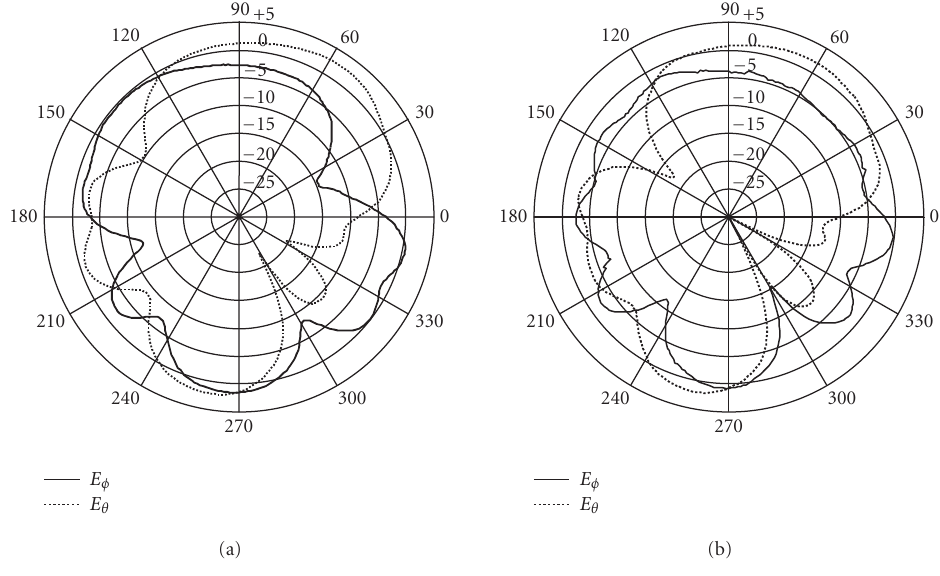
Figure 6: Measured radiation patterns (copolar and cross-polar) for two of the PIFAs in the outdoor-to-indoor campaign (Figure 5c) in the plane perpendicular to the faceplate and parallel to the length axis of the terminal: (a) top left antenna and (b) top right antenna. The amplitudes along the radial are in